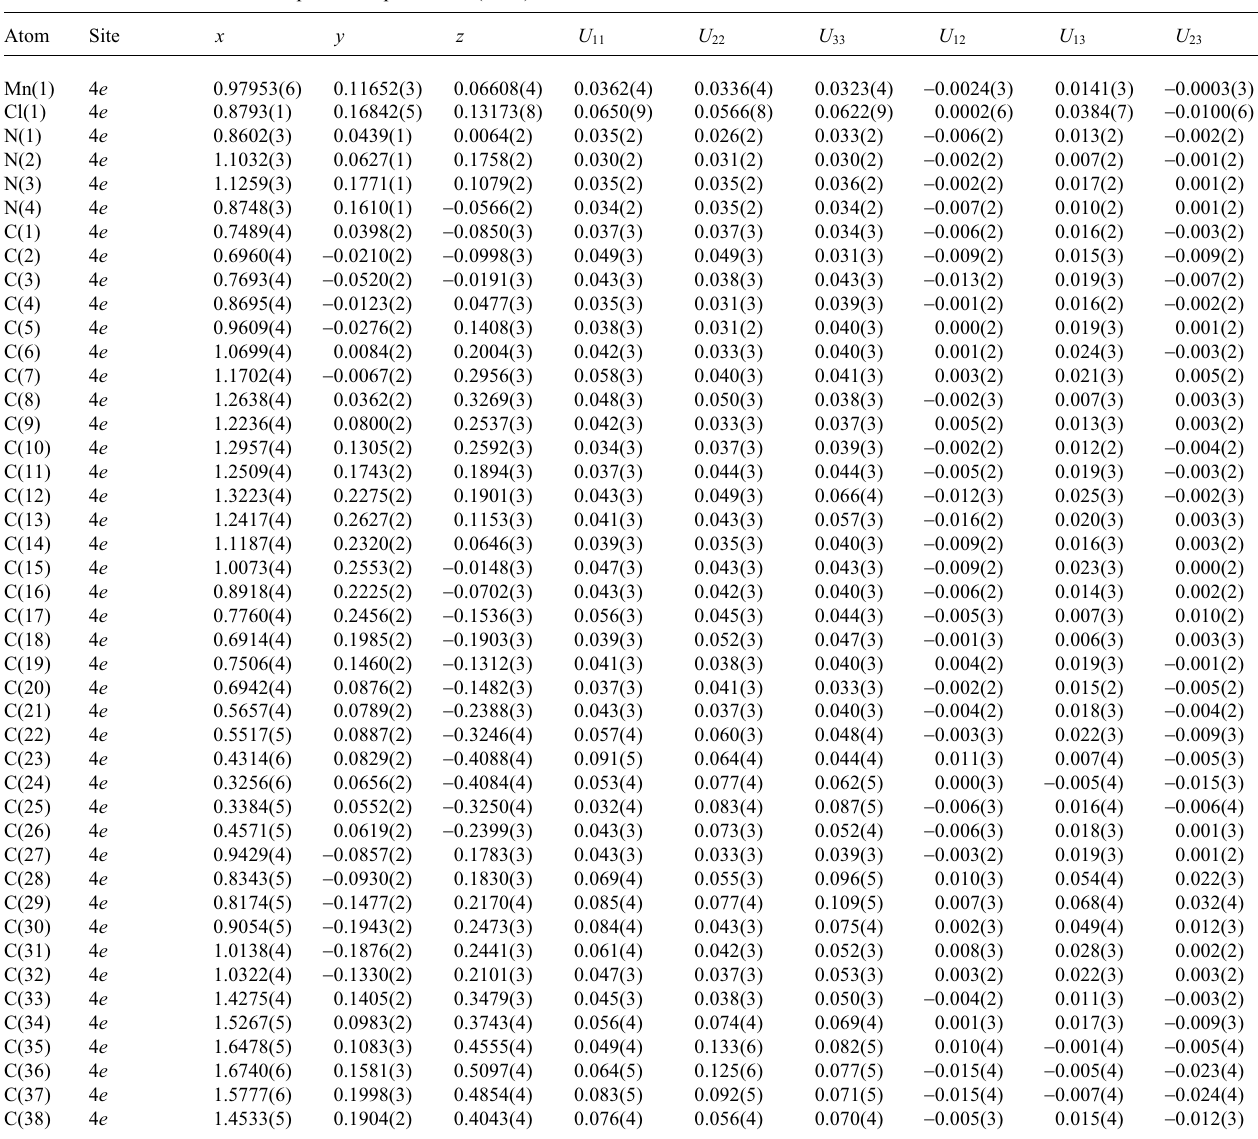
Table 3. Atomic coordinates and displacement parameters (in Å 2 )